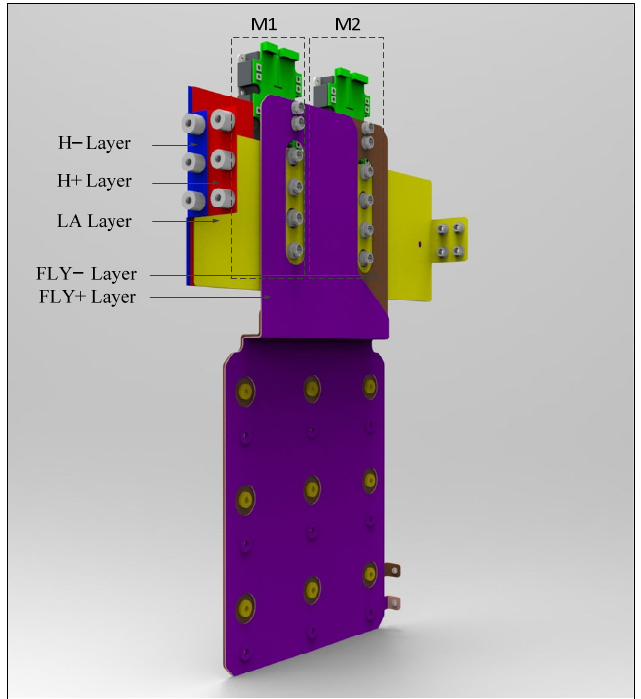
Figure 9. The physical placement of IGBT devices and polarity assignment of bus bar for the PEBB of FC ‐ 3L ‐ BDC.